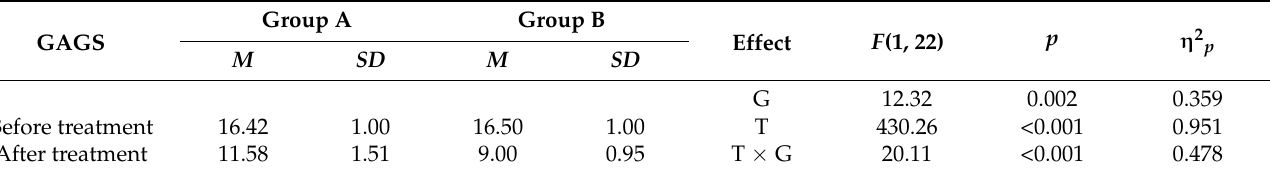
Table 1. Repeated measures of one-way ANOVA for acne severity in groups A and B, before and after treatment, using the Global Acne Grading System (GAGS).